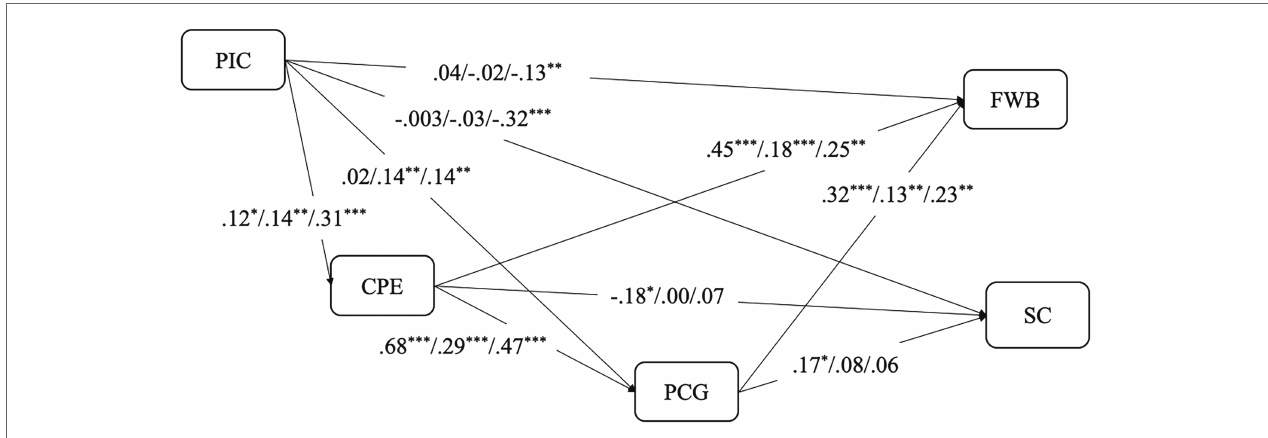
FIGURE 3 | Path estimates for the Chinese, German, and United States samples of PIC on FWB and SC mediated by CPE and PCG. * p < 0.05; ** p < 0.01; *** p < 0.001. Standardized path coefficients. For each path, the first, second, and third coefficients are the estimate of Chinese, German, or United States sample,